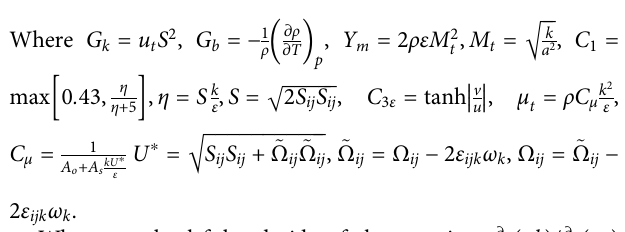
FIGURE 3 | Computational Domain and Boundary